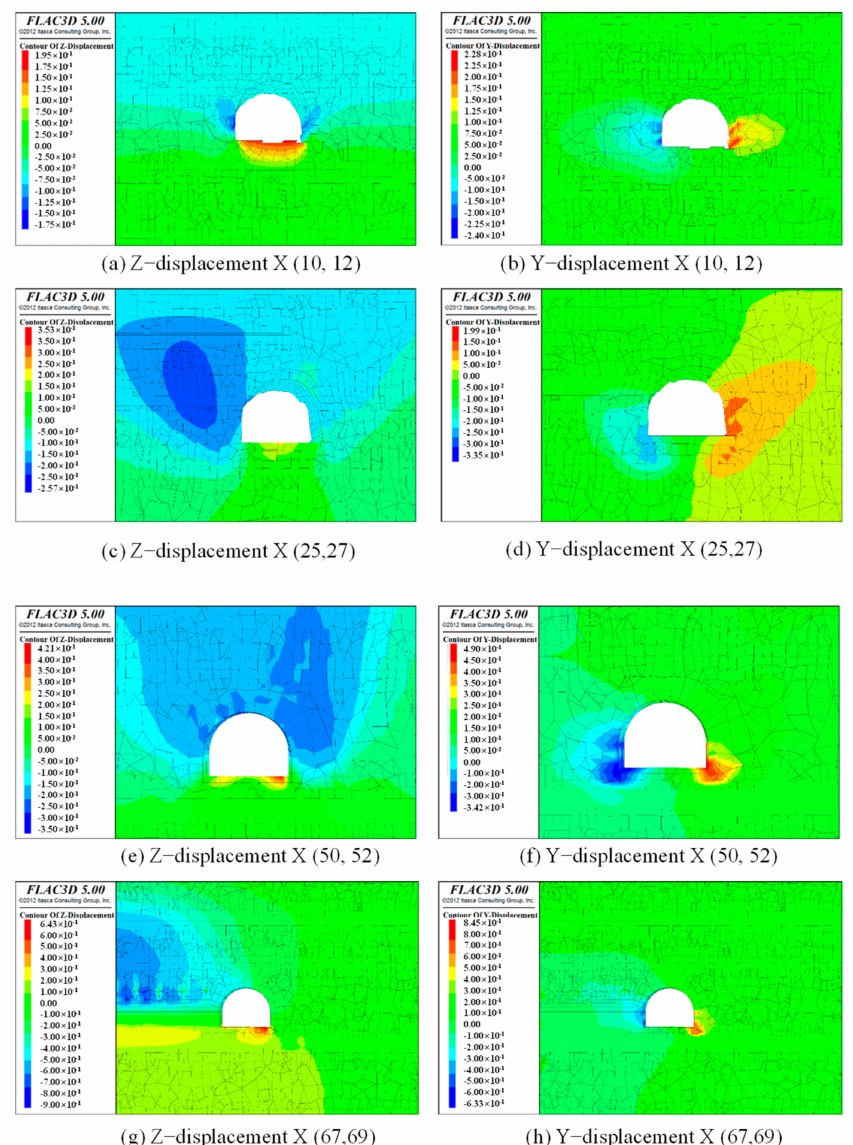
Figure 20. Main inclined shaft and supporting state after excavation of electromechanical